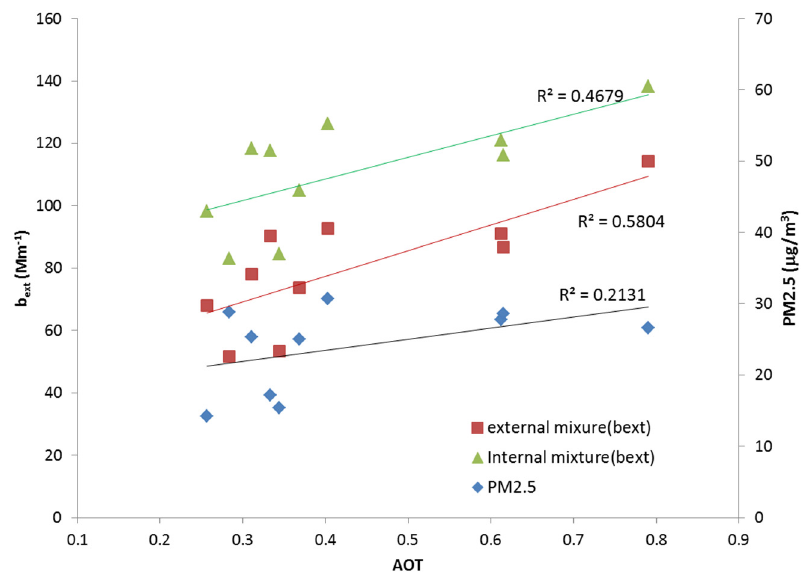
Figure 3. Comparison of the PM 2.5 mass concentration and extinction coefficient ( λ = 550 nm) with different mixtures verses Aerosol Optical Thickness (AOT) from AERONET.